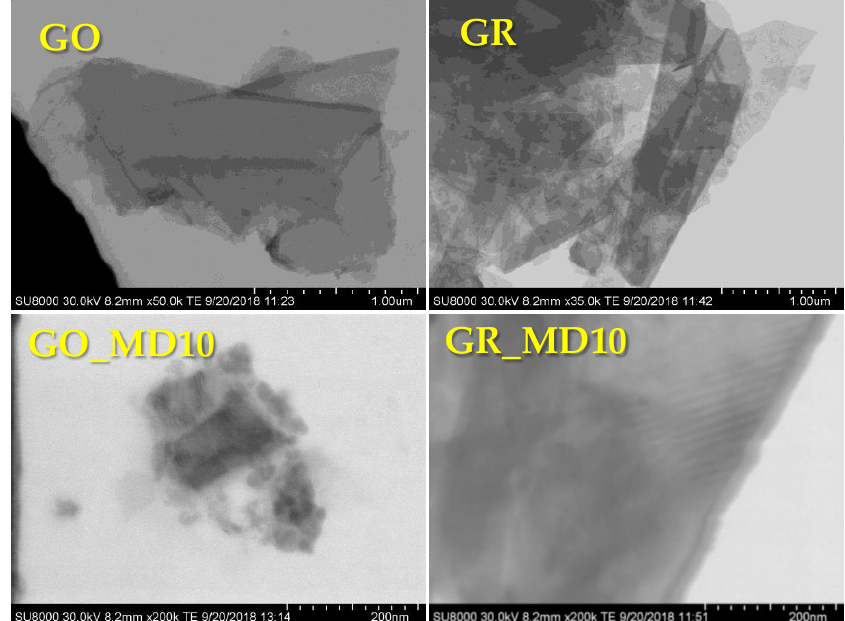
Figure 4. FESEM images of GO and GR and functionalized hybrid materials with MD10.